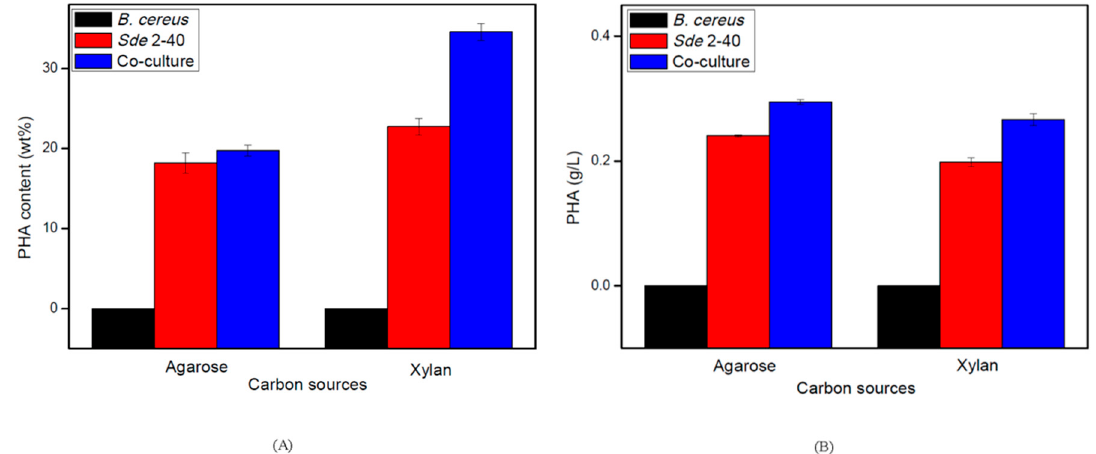
Figure 8. Production of PHA in one step culture in nutrient balanced medium. ( A ) PHA contents of Sde 2-40, B. cereus , and co-culture on agarose and xylan; ( B ) PHA concentrations of Sde 2-40, B. cereus , and co-culture on agarose and xylan.